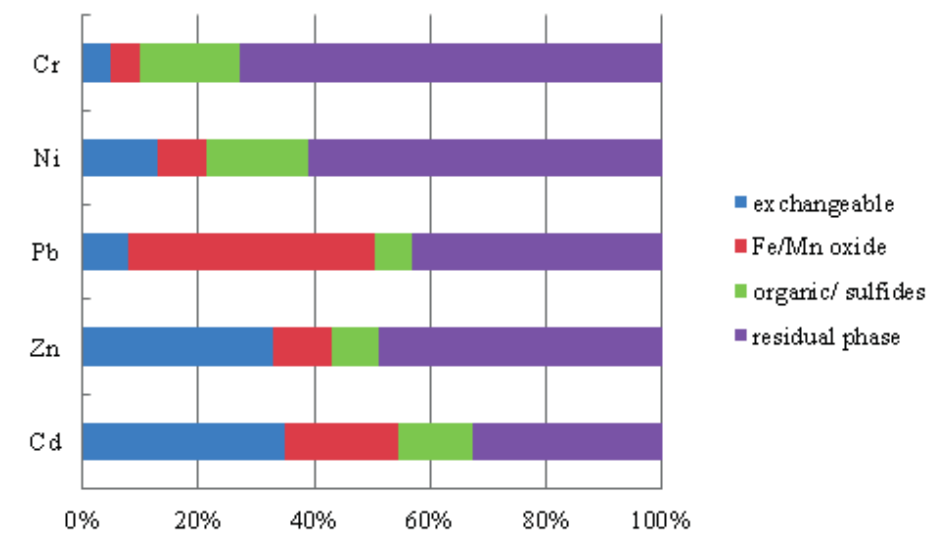
Figure 4. Partitioning of heavy metals in the